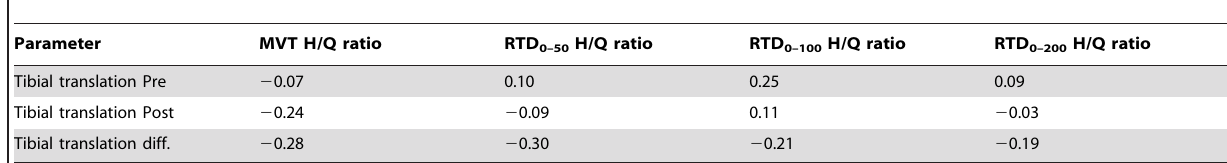
Table 2. Correlations between posterior-anterior tibial translation and strength parameters for all